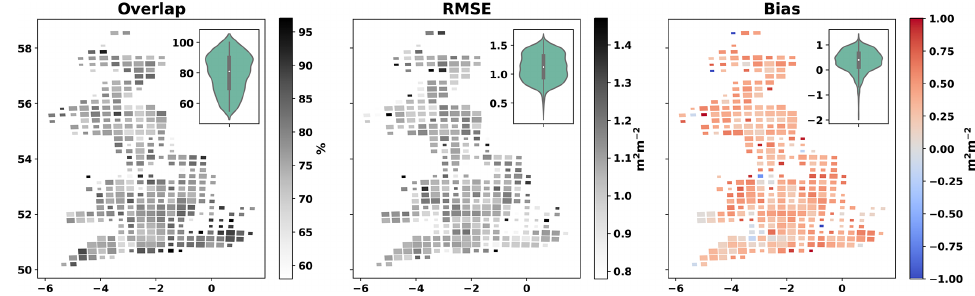
Figure A2. Cartograms of overlap (%), root mean square error (RMSE) (m 2 m − 2 ), and bias (m 2 m − 2 ) between MDF-predicted and assim- ilated LAI (EO-based). The size of cells is adjusted according to the number of simulated fields within it. The violin-plot insets present the distribution of each evaluation metric across all simulated fields.